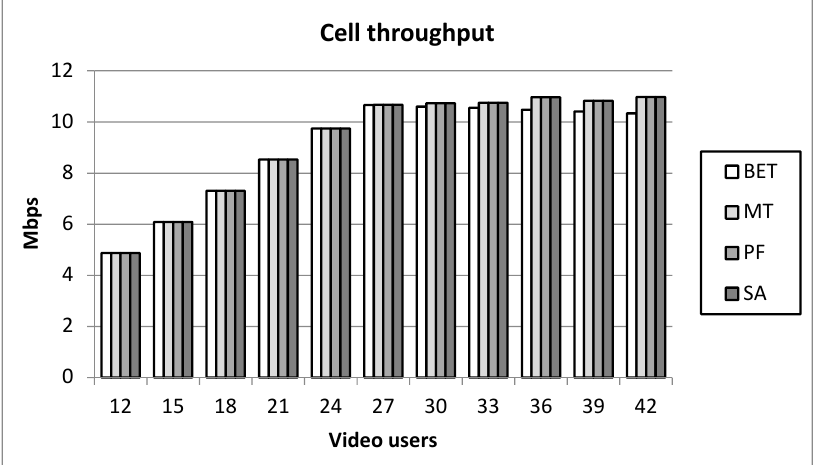
Figure 2. Uplink cell throughput for video users.